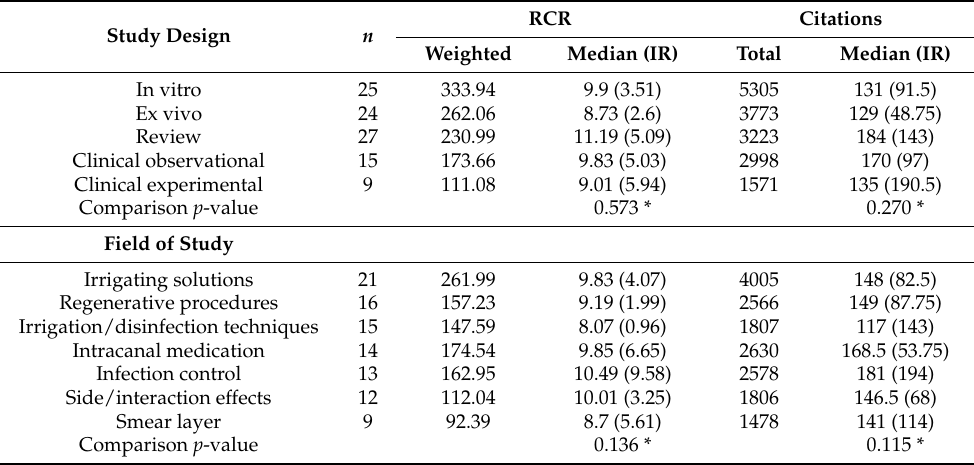
Table 5. Study design and field of study of the top 100 most influential articles in root canal disinfec- tion by the highest RCRs. 1990–2019. Weighted RCR, total citations. Median (interquartile range).